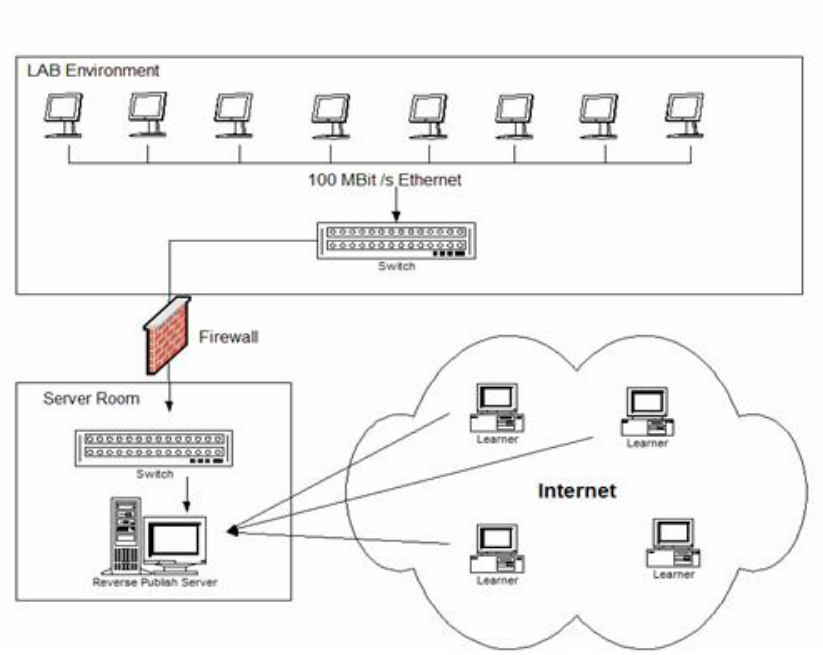
Figure 1. Remote Access to Analytical